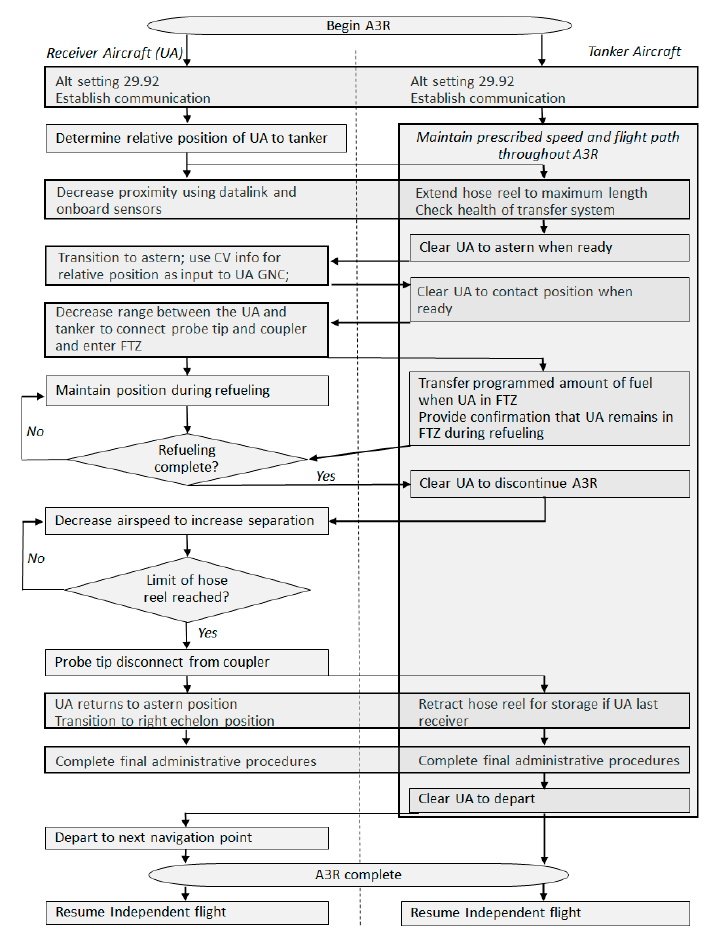
Figure 9. Process map of the A3R tasks.